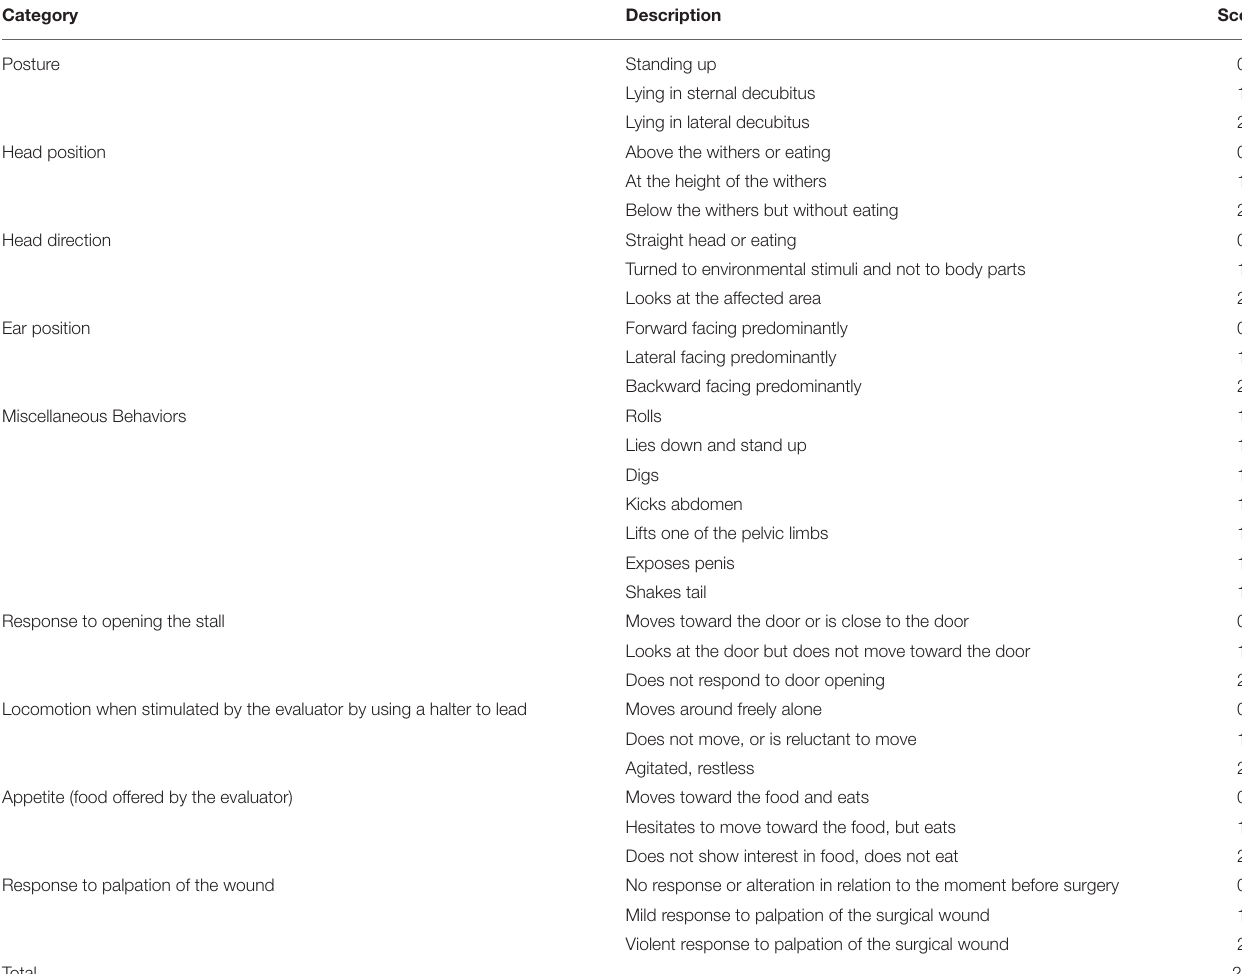
TABLE 2 | Acute pain scale used for the analysis of videos of donkeys submitted to castration before